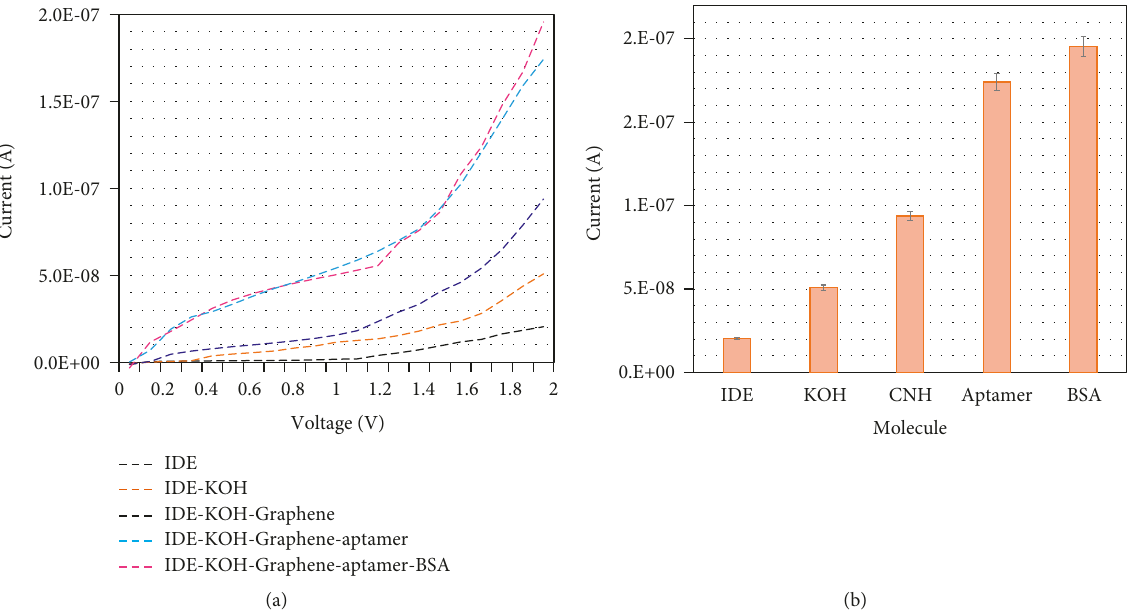
Figure 3: (a) Surface functionalization for anti-CEA aptamer immobilization. The electrochemical response for each process was recorded, and the immobilization was confirmed. This increment in response clearly indicates the attachment of the anti-CEA aptamer on the electrode surface. (b) Electrochemical response for anti-CEA aptamer attachment. The difference in response is observed to be much higher after the introduction of the aptamer on the sensing electrode surface, which confirms that the surface is modified with the anti-CEA aptamer process. The averaged values obtained from the replicates are displayed by the error